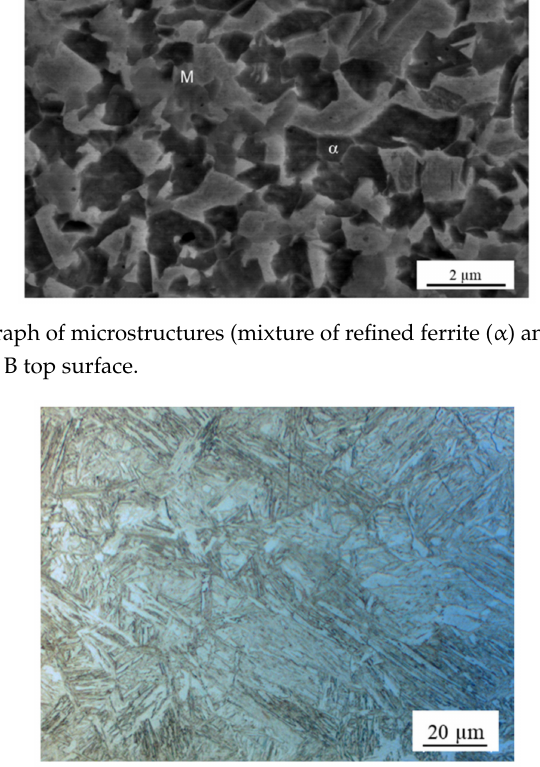
Figure 9. Optical microcopy image of microstructure (fully martensite) at the top surface for sample